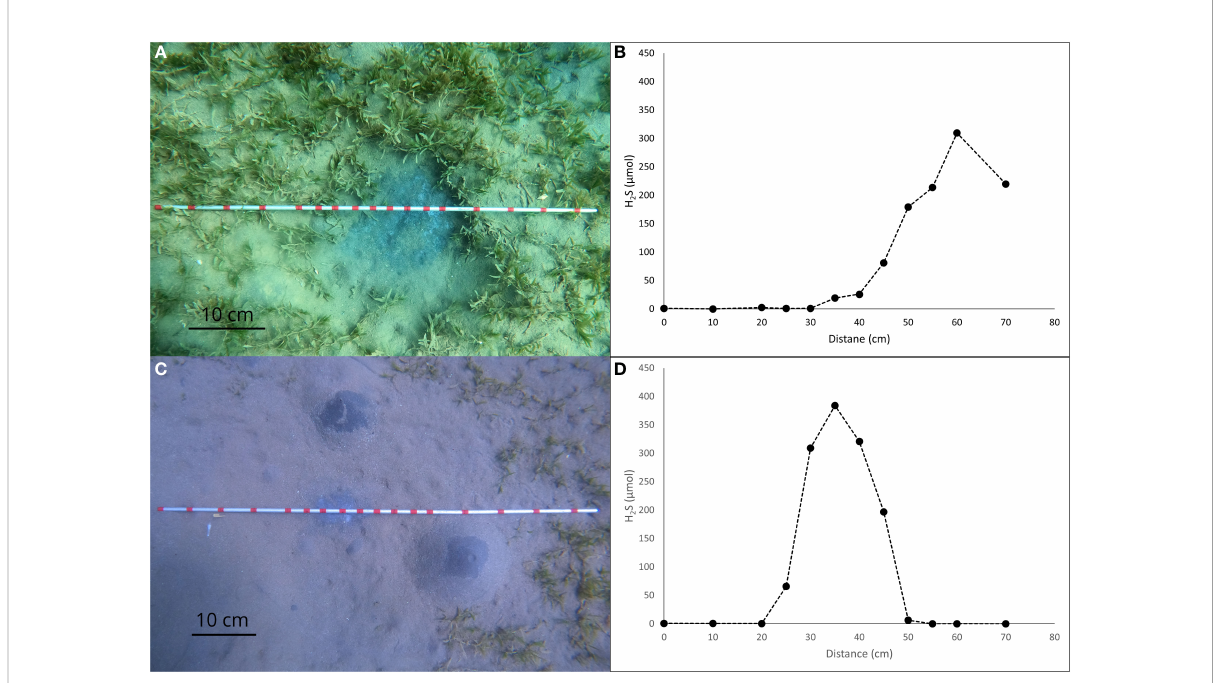
FIGURE 7 Photographs taken by the authors showing the line transect method for collecting pore water at a seagrass (A) and a non-seagrass (C) habitat. Collections were made at the red marks which are 5 cm apart. H 2 S concentration in the pore water as function of the sampling position in the sediment patch at a seagrass (B) and a non-seagrass (D)